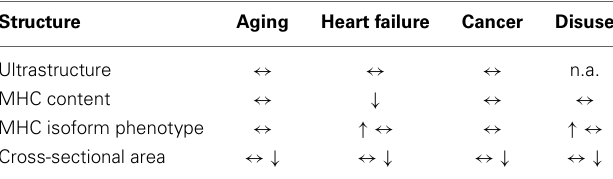
Table 1 | Summary of structural changes in single fiber and myofilament structure with aging, disease, and disuse.